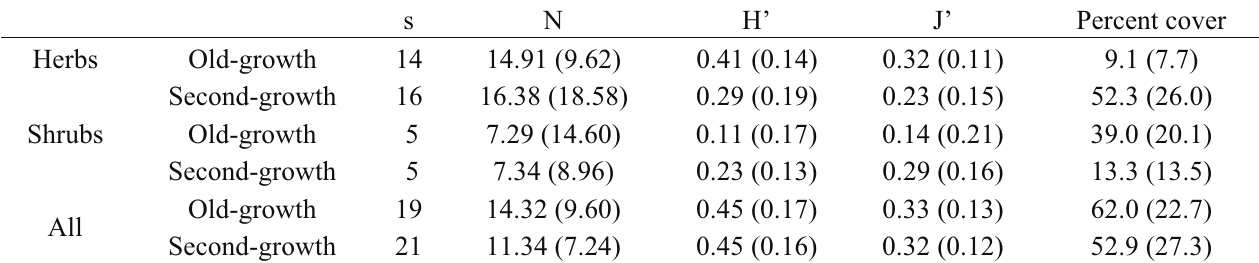
Table 3. Total number of understory species (s), average percent cover of individuals (N), Shannon diversity (H’), evenness using H’ (J’) average total percent cover for adjacent old-growth and second-growth riparian stands in Redwood National Park, USA (standard deviation in